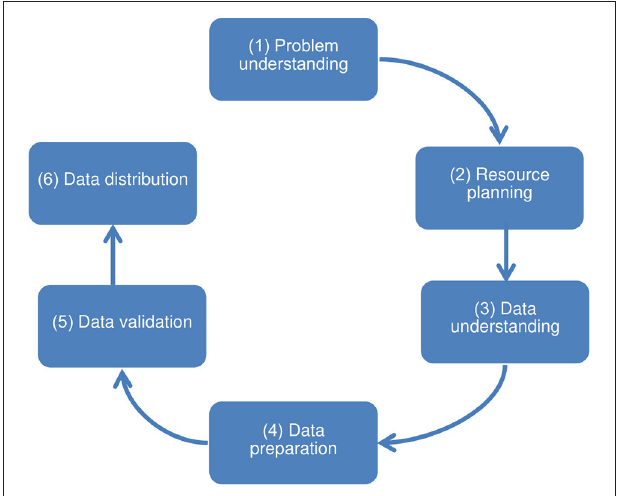
FIGURE 1 | Steps toward ensuring the adequacy of structured secondary health data for use in quantitative